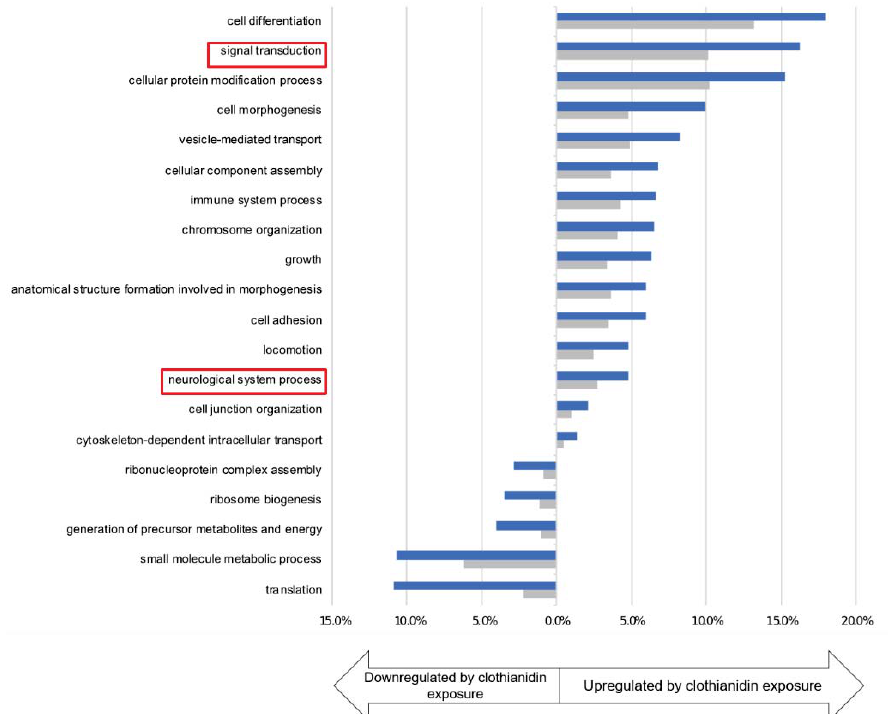
Figure 4. Exposure to clothianidin deregulates gene expression in the brain of A. ipsilon . Gene Ontology Enrichment analysis showing the GO terms of genes deregulated by clothianidin exposure compared to DMSO and controls (test set, blue) and that exhibit statistical significant differences with GO terms of to the whole transcriptome (reference set, grey) (Fisher exact test, FDR < 0.1). The X -axis shows the percentage of sequences in each dataset. The Y -axis shows the GO terms. Upregulated genes are shown on the right of the figure, downregulated genes on the left. The two categories that are relevant to our study, “signal transduction” and “neurological system process”, are highlighted with a red box.